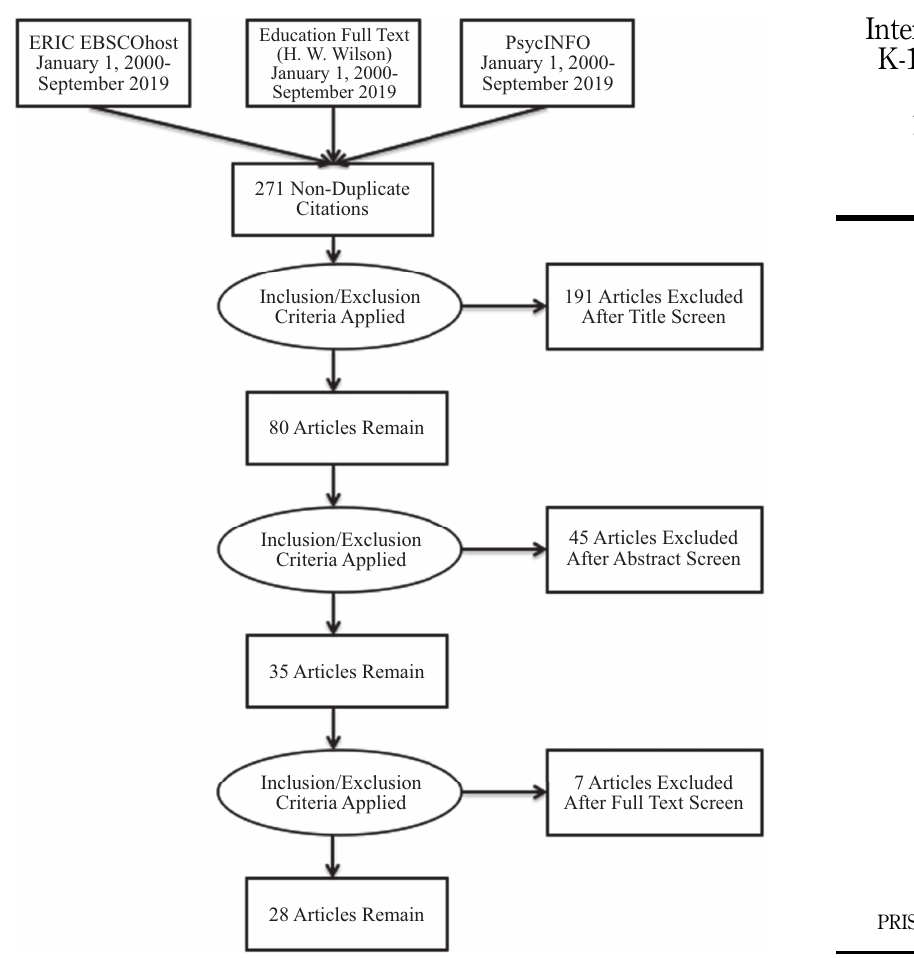
Figure 2. PRISMA